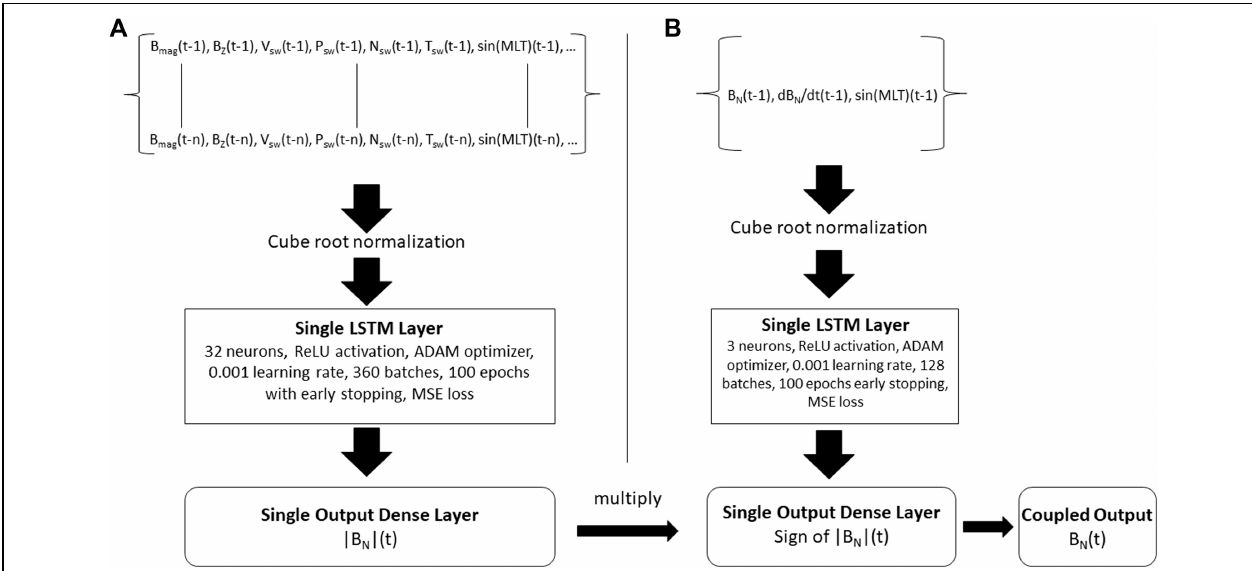
FIGURE 1 | Subfigure (A) showcases the setup of the LSTM | B N | model utilized in the study. The inputs are structured in a 2D array where each column is one feature of the solar wind and IMF inputs detailed in Section 2.2 while the rows refer to each of the features at a previous time point from t−1 to t−n, where n is the amount of time history selected. The input array is provided directly to the LSTM model which sends the output to a single dense layer to provide the final output. In subfigure (B) the polarity model is displayed in a similar manner to the LSTM model of subfigure (A) . The input array is a 1D array sent to an LSTM model which sends the final prediction to a single dense layer. The output of the polarity model is decoded and multiplied against the LSTM | B N | model to obtain the coupled